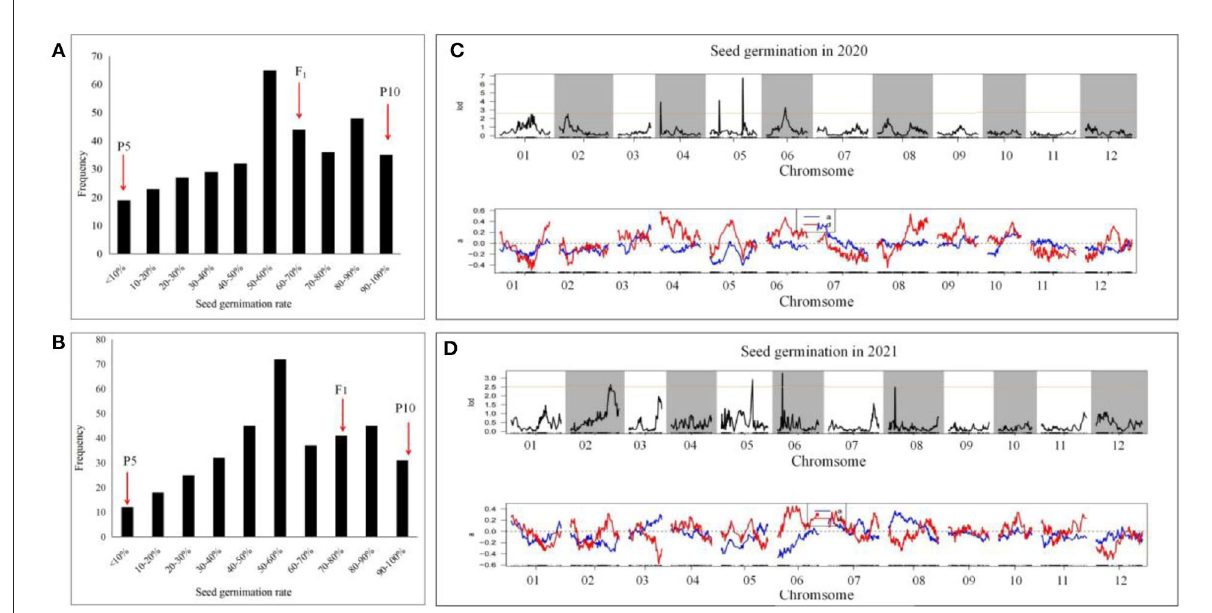
FIGURE3 Seed germination segregation of F 2 : 3 generation and QTL preliminary detection using previously constructed genetic map. The average data for seed germination of F 2 : 3 families with each family containing 10 fruits were collected in 2020 and 2021, respectively. (A,B) the distribution of seed germination in 2020 and 2021. (C,D) QTL detection for seed germination in 2021 and 2021. For the upper map, numbers to the abscissa axis was each chromosome (Chr) and the map length in centiMorgan (cM), and the vertical bars represent 2.5 LOD support interval of each QTL. For the blow map, those indicated the additive effects for the QTL